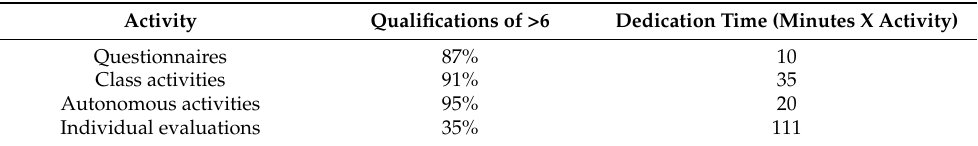
Table 2. Identification of the time of dedication in the development of activities vs. the percentage of students who have achieved a grade point average above